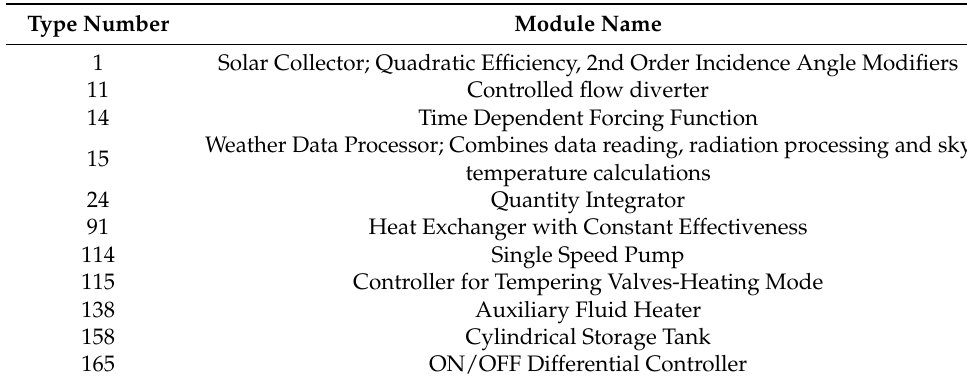
Figure 1. Scheme of the model of SDHW system developed in the TRNSYS software environment. Table 1. List of the main modules of the SDHW system model.